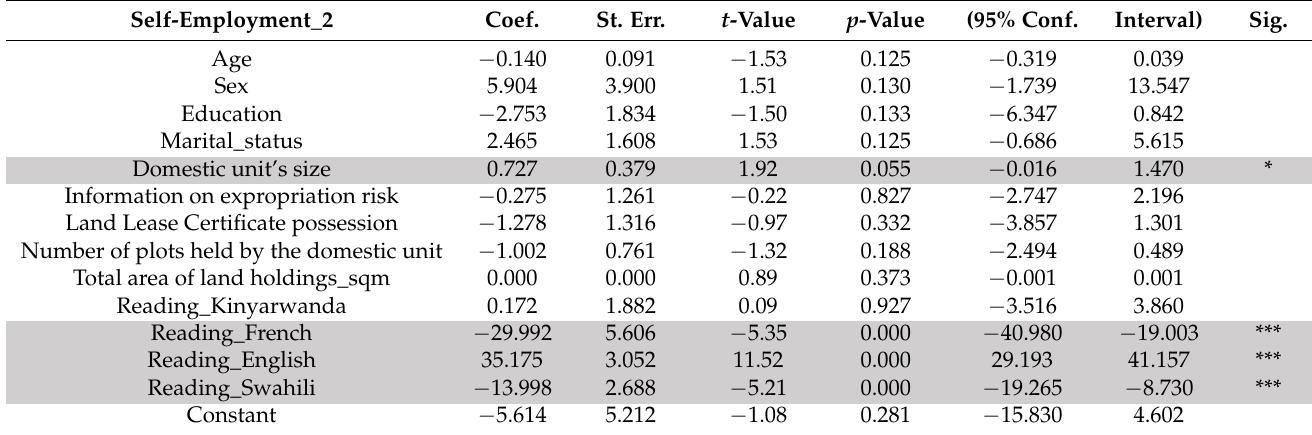
Table 6. Factors affecting the decision of the head of a domestic unit to become involved in a second activity as self-employed. Self-Employment_2 Coef. St.